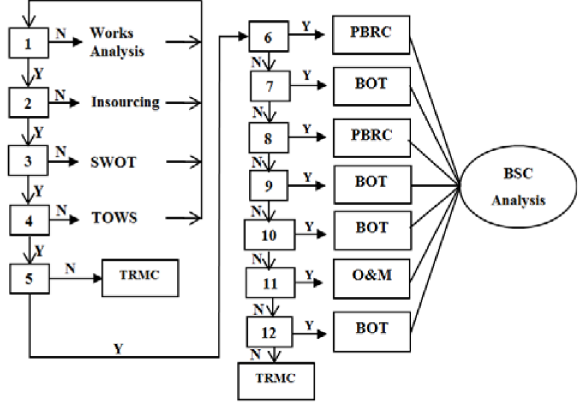
Fig. 1. Road Maintenance outsourcing Alignment